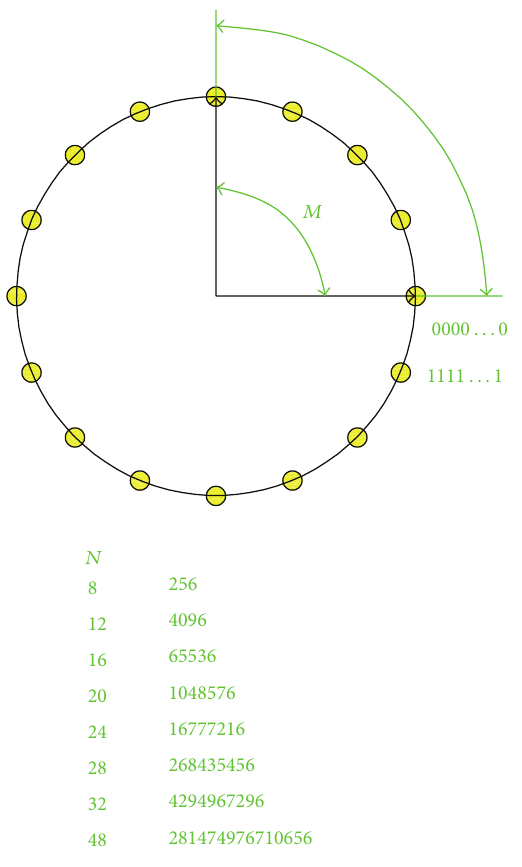
Figure 1: Diagrammatic sketch of the operating principle of phase accumulator.